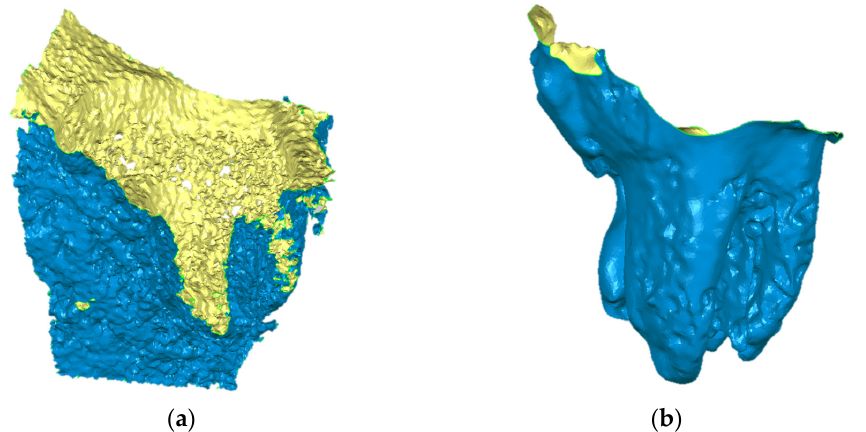
Figure 6. Extracted volume of alveolar cavity ( a ) before mesh processing and ( b ) after mesh processing where the cavity of the alveolus of the extracted tooth is isolated.